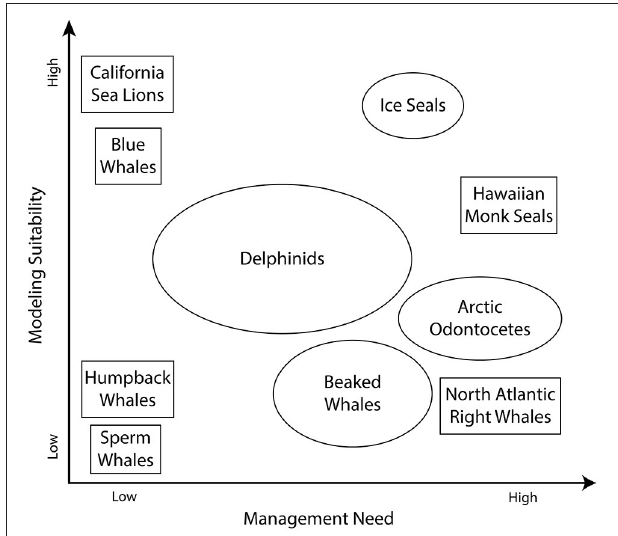
FIGURE 2 | The range of increasing modeling suitability and management need for some illustrative marine mammal populations. Species and their relative positions are provided for illustration purposes and may not indicate an official agency